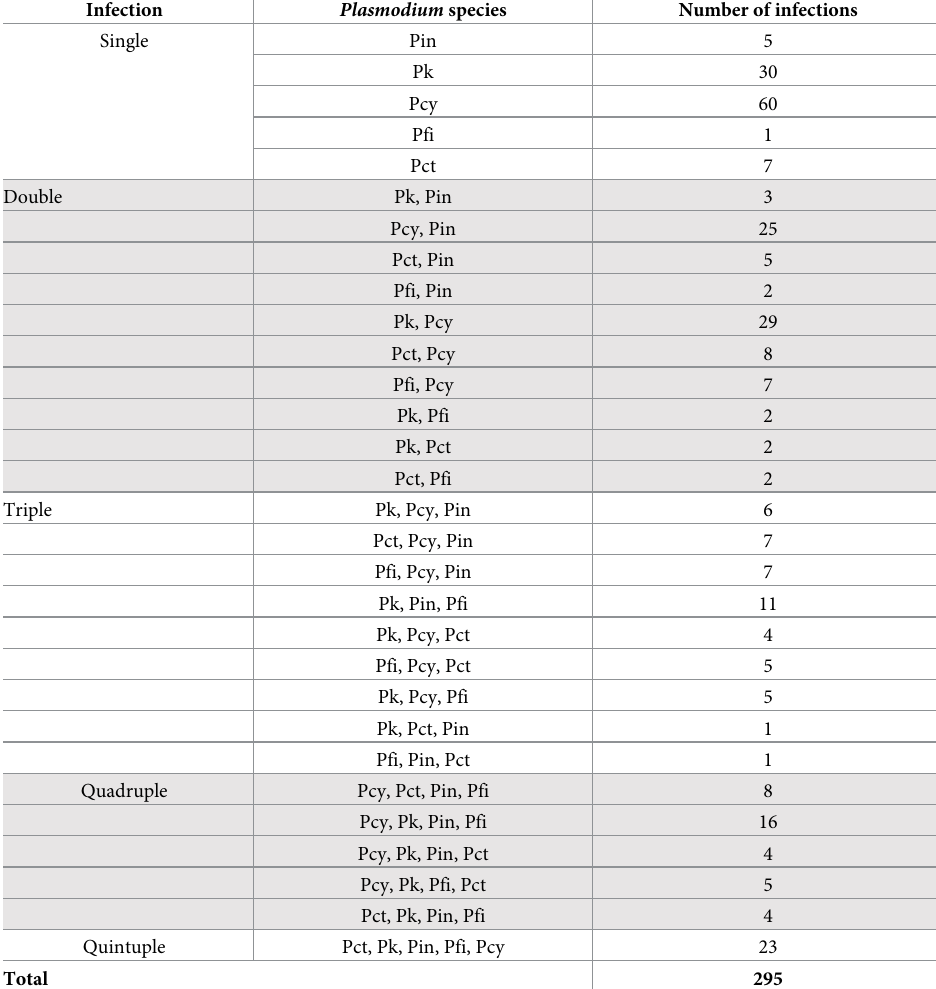
Table 2. Breakdown of malaria infections based on species-specific PCR assay in infected